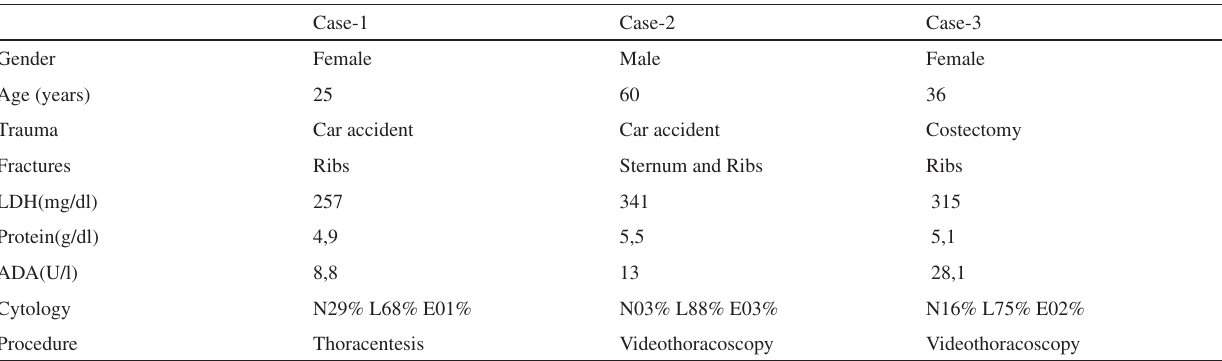
Table 1 - Clinical data and pleural fluid